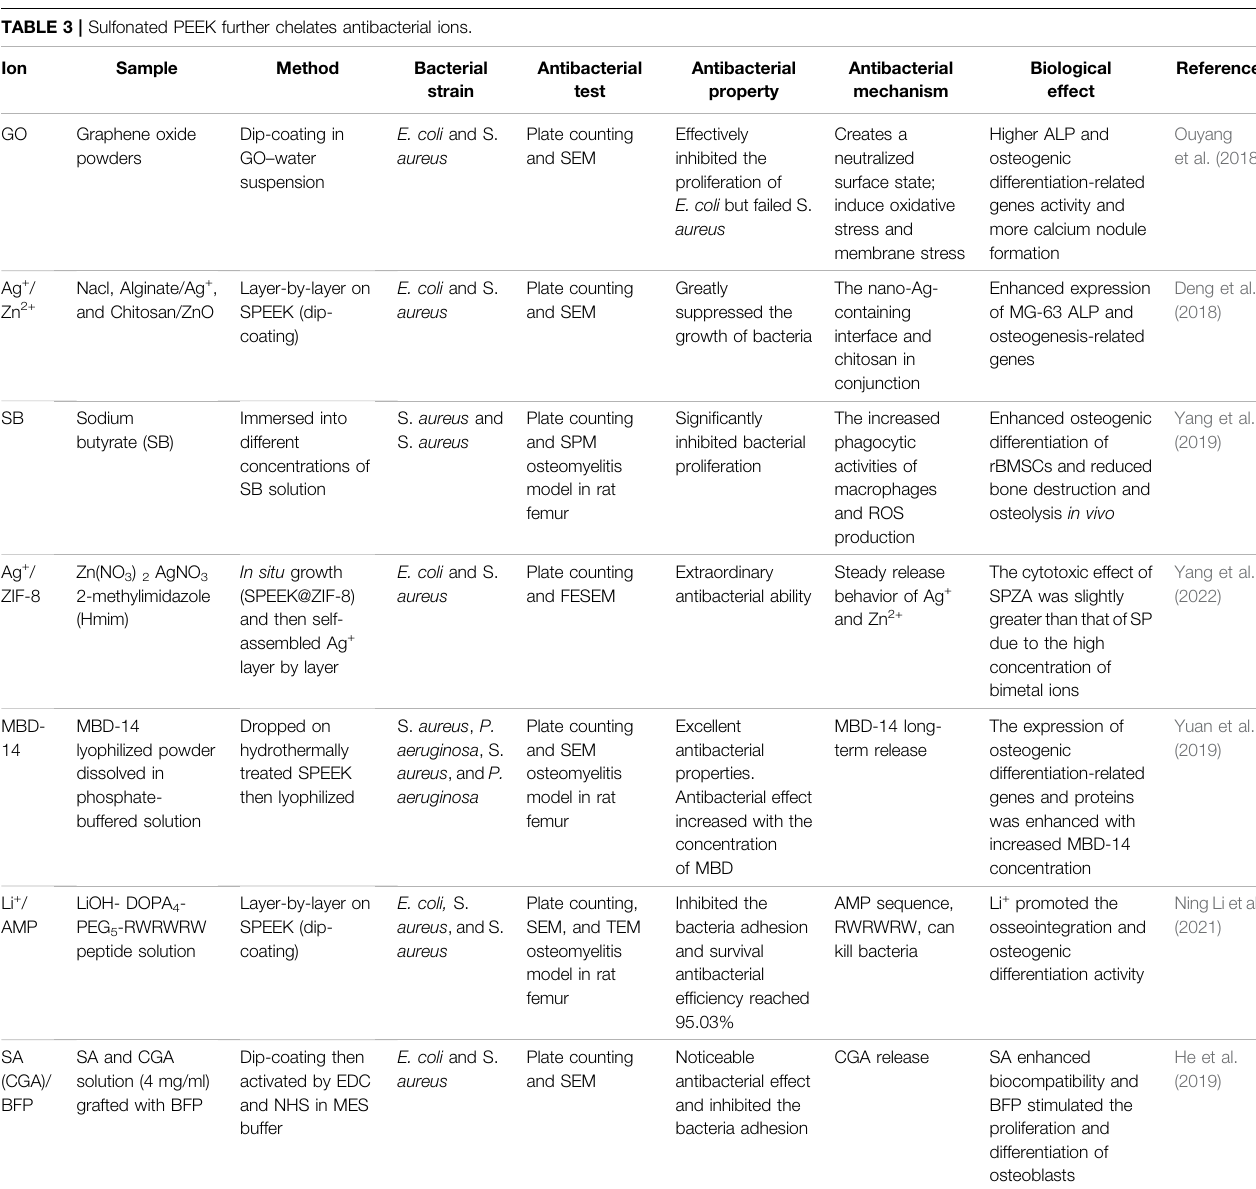
TABLE 3 | Sulfonated PEEK further chelates antibacterial